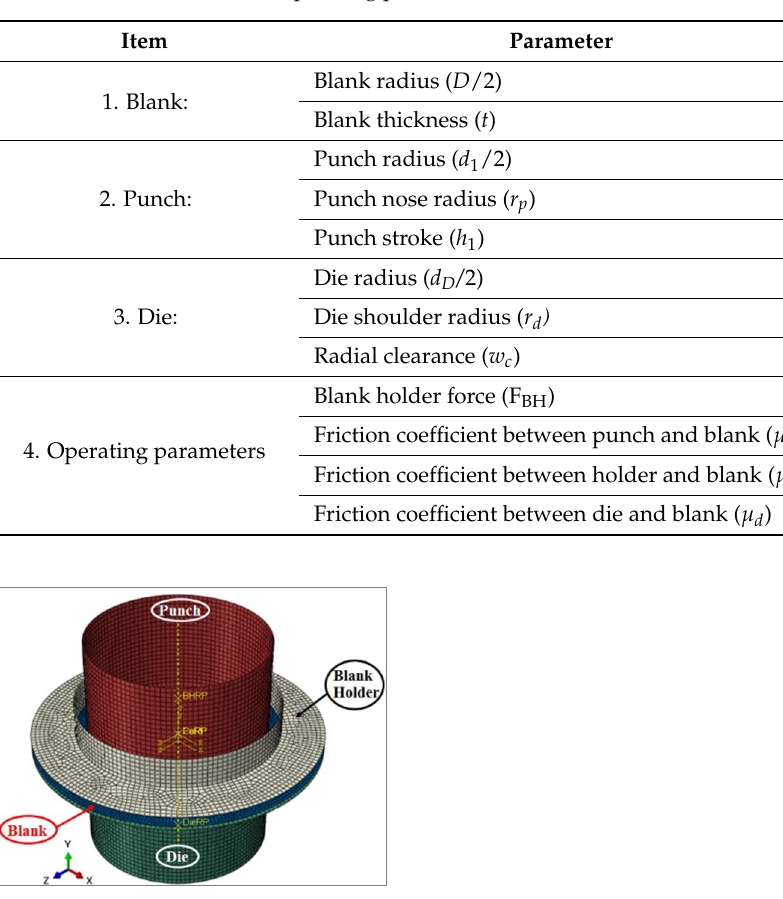
Figure 1. Assembly and dimensions of the deep drawing die. Table 1. Geometrical and the operating parameters.